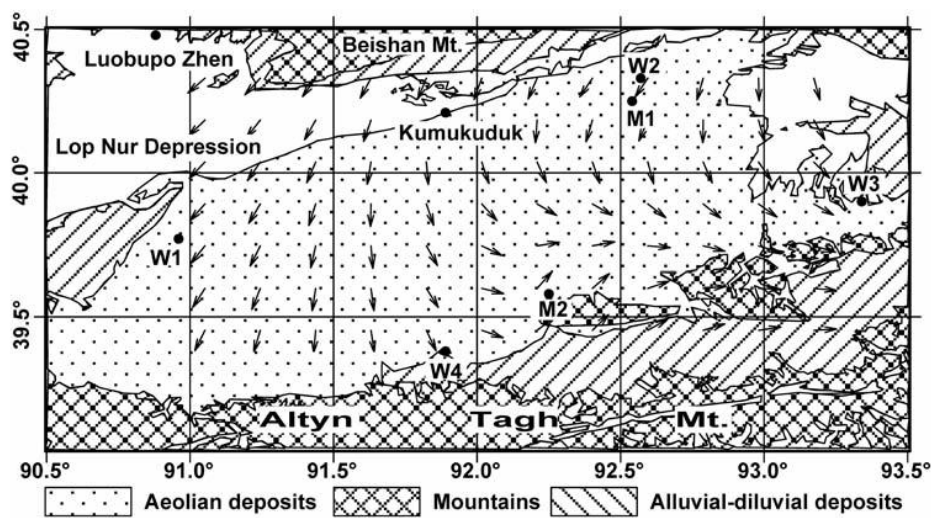
Fig. 2. Wind regimes in the Kumtagh Figure 2 Wind regimes in the Kumtagh Desert